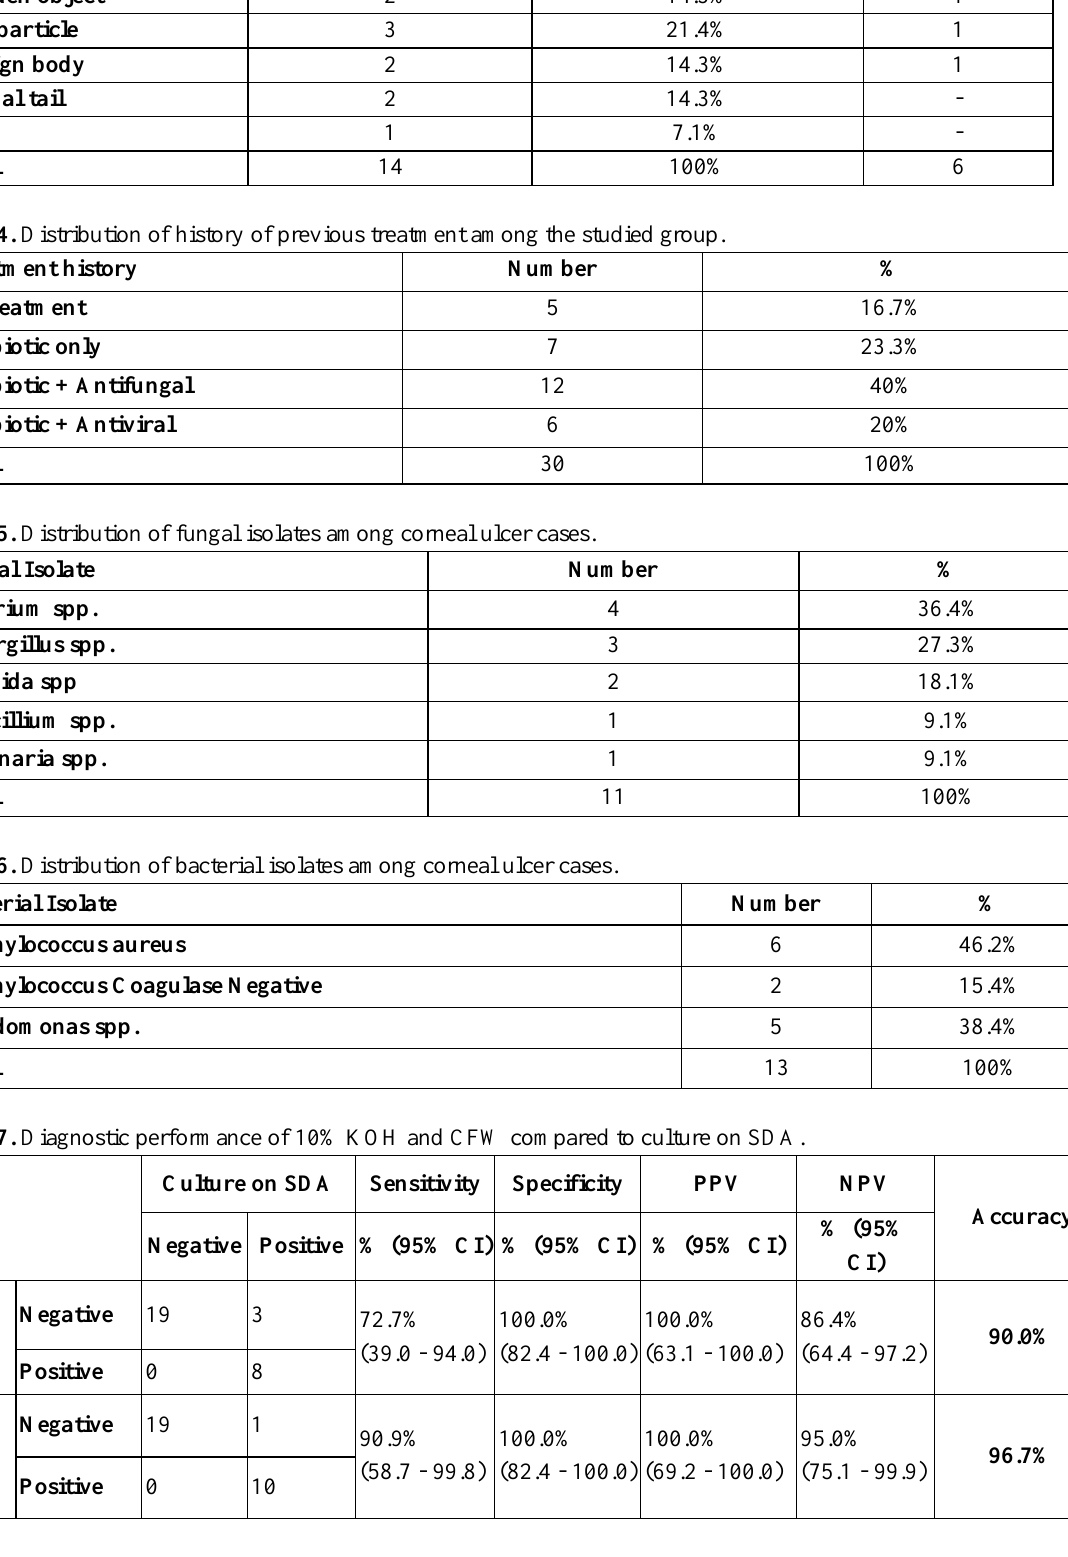
Table 3. Distribution of mode of trauma among the studied group. Mode of Trauma Vegetative matter